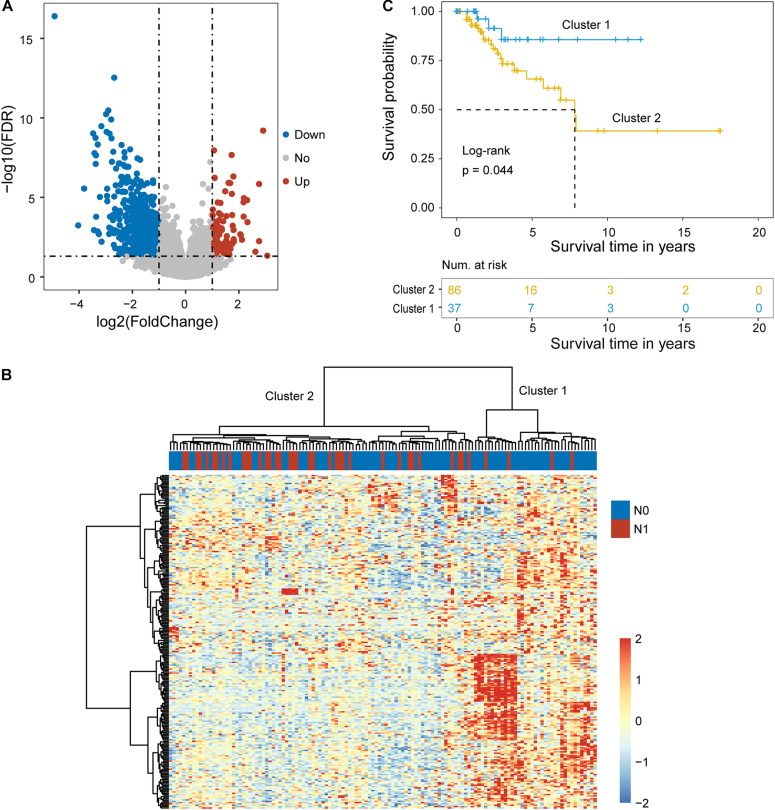
Identification of candidate biomarkers related to lymph node metastasis. (A) Volcano plot displaying differentially expressed mRNAs and lncRNAs between cervical cancer patients with and without lymph node metastasis. (B) Unsupervised clustering of patients based on the expression levels of differentially expressed mRNAs and lncRNAs. (C) Kaplan-Meier survival curves of patients in cluster 1 and cluster 2.